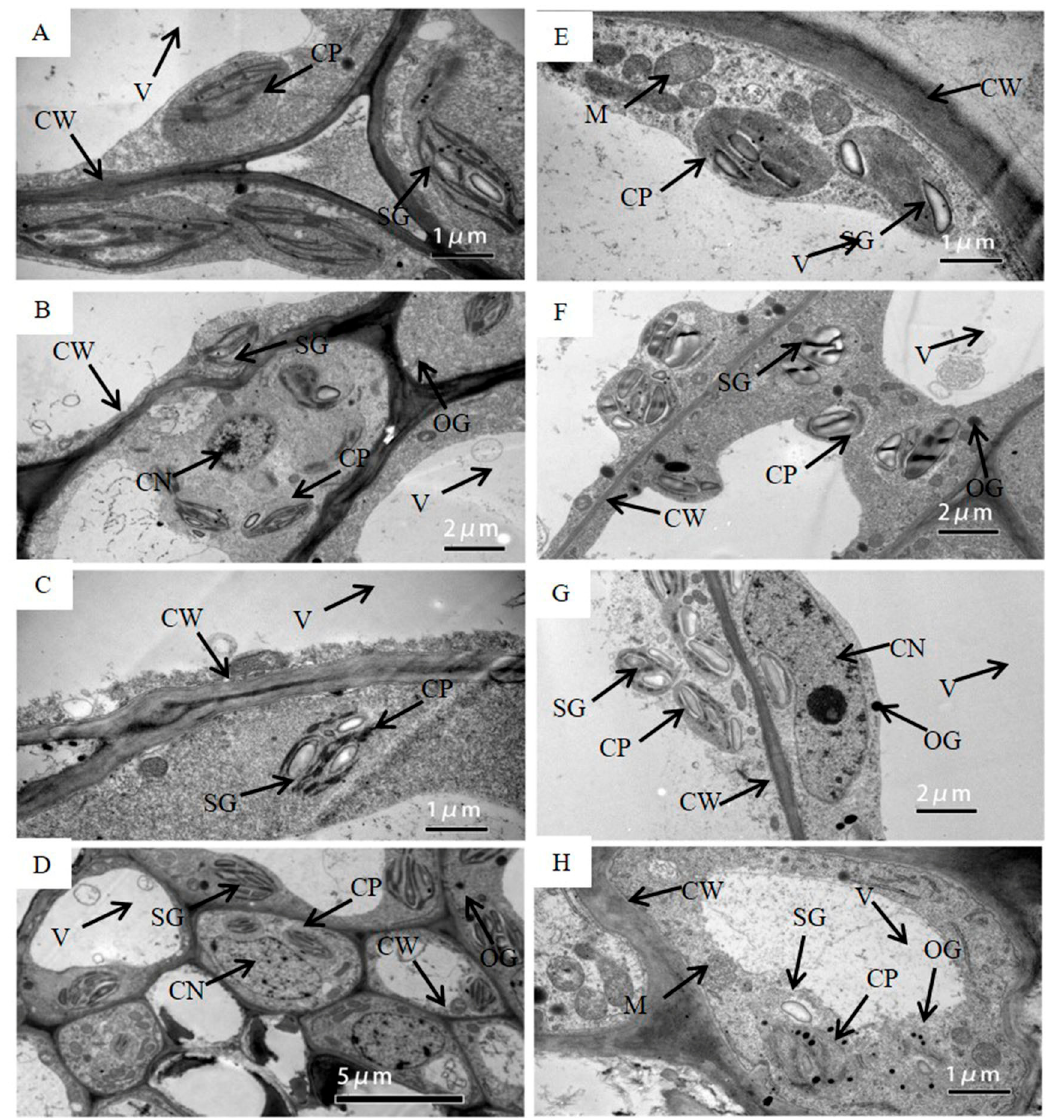
Figure 2. The transmission electron micrograph of cells in the pod wall on DAP5 ( A , E ), DAP10 ( B , F ), DAP15 ( C , G ), and DAP20 ( D , H ) under well-watered ( A – D ) and water-stressed treatment ( E – H ). CW, cell wall; CP, chloroplast; SG, starch grain; OG, osmiophilic granules; V, central vacuole; CN, cell nucleus; M, mitochondrion; T, thylakoid.